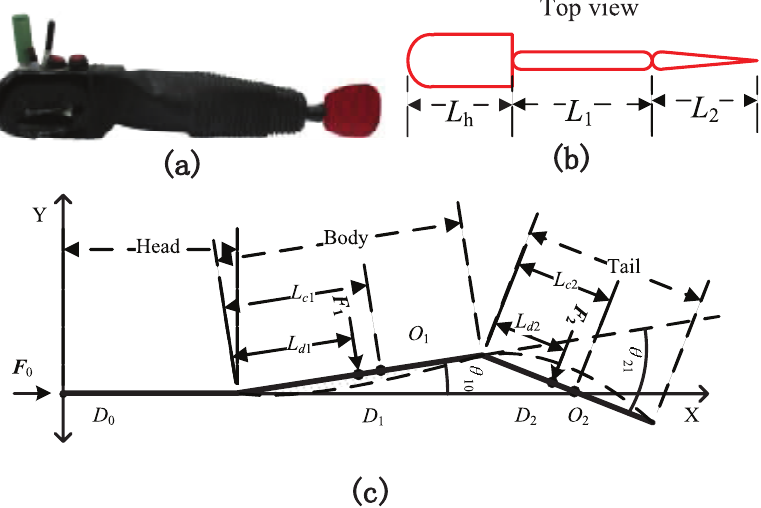
Figure 1. Model of the two-joint robotic fish: ( a ) the prototype of the robotic fish, ( b ) the top view of the robotic fish, and ( c ) the geometry parameters of the robotic